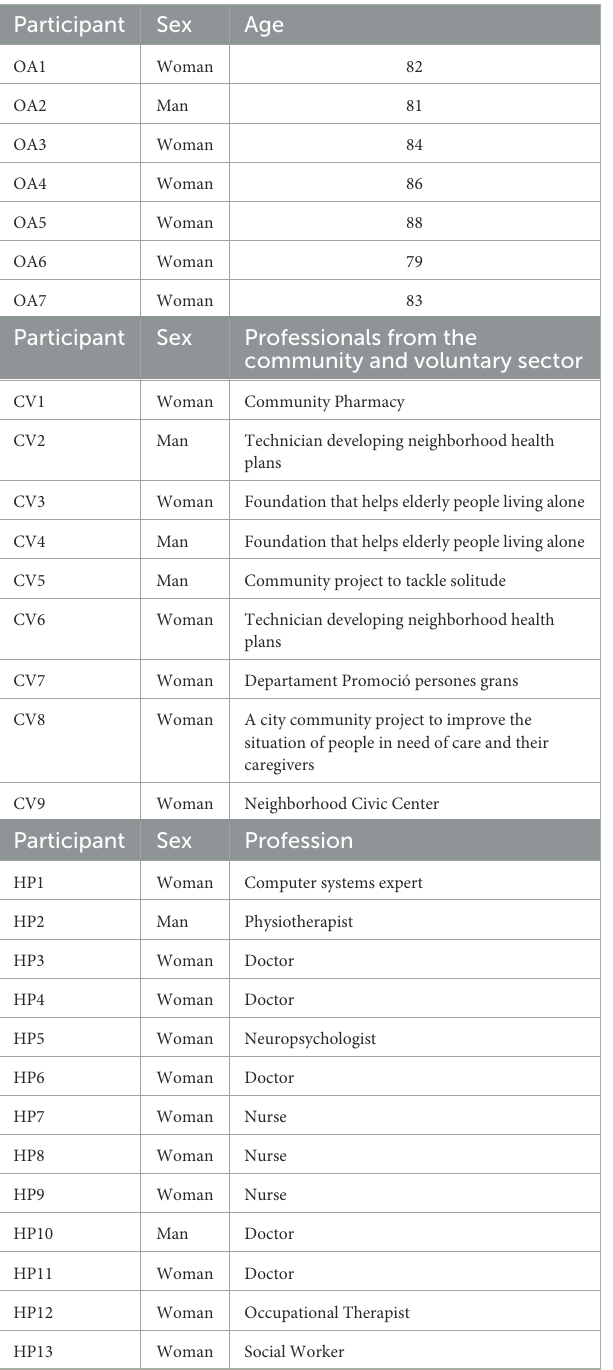
TABLE 1 Characteristics of the